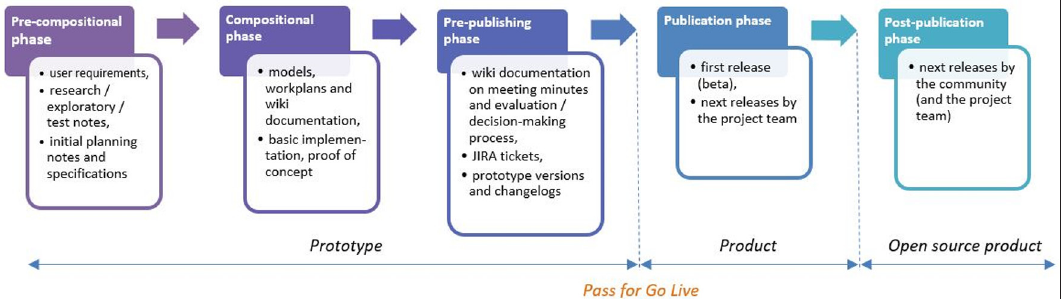
Figure 2: Chrono-typology of documents in the production of an open-source